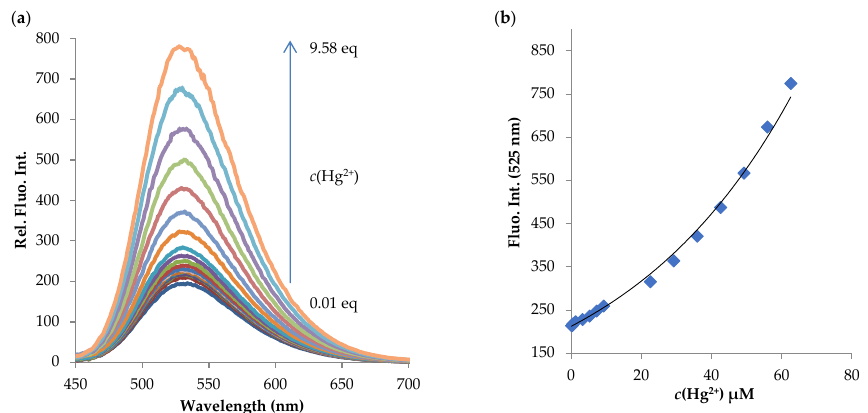
Figure 10. ( a ) Fluorescence titration spectra of NI-2 (5.00 × 10 − 7 M) with Hg 2+ in concentration range 1.31 × 10 − 7 M–2.26 × 10 − 5 M (shown in the graph ranging from 0.01 eq to 9.58 eq) in MeOH/buffer (1/2, v / v , pH = 5.5), λ exc = 410 nm. ( b ) Plot of fluorescence enhancement at 525 nm of NI-2 as a function of Hg 2+ ion concentration.